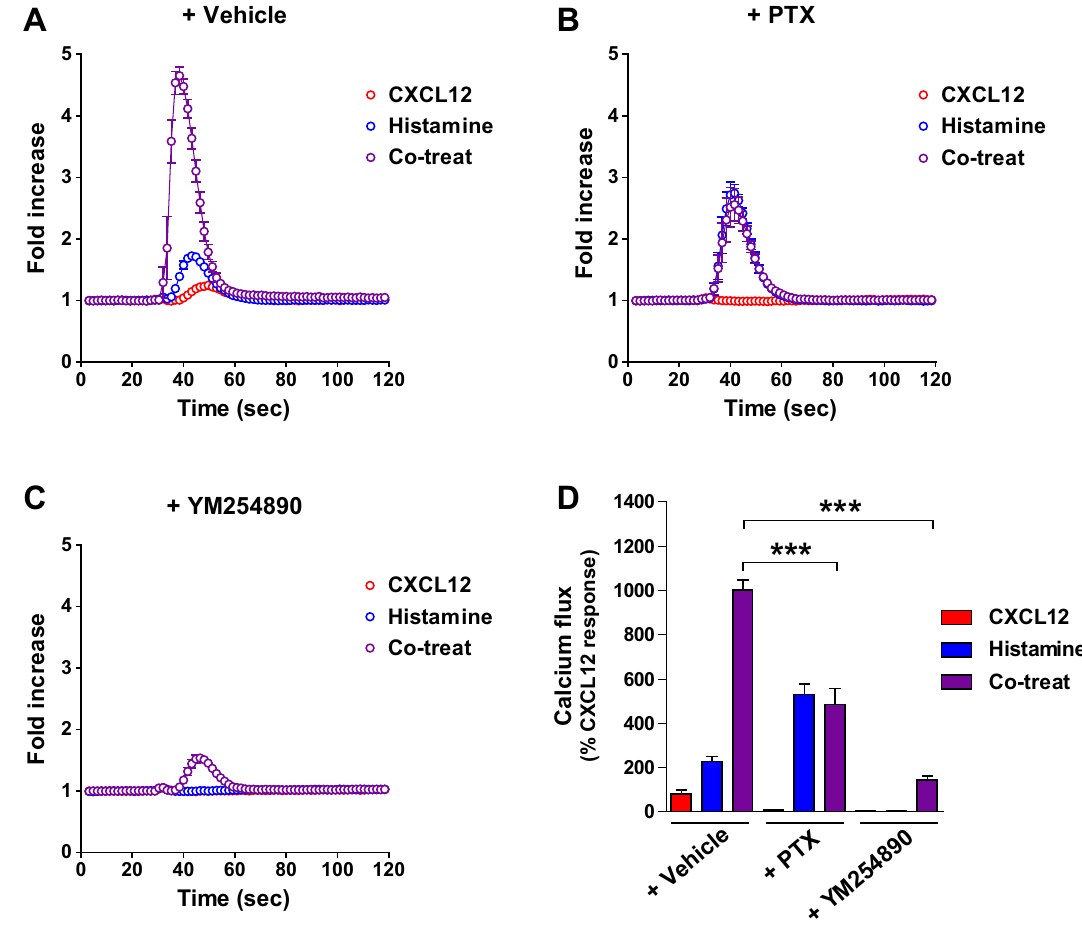
Figure 5. Activation of both Gα i/o and Gα q/11 is important for synergistic calcium mobilization induced by costimulation of CXCR4 and HRH1. MDA-MB-231 cells were pretreated with vehicle ( A ), PTX (100 ng/ml, overnight) ( B ), or YM254890 (300 nM, 30 min) ( C ) prior to agonist treatment. Cells were stimulated with 3 nM CXCL12, 100 nM histamine, or both, and intracellular calcium flux was measured. ( D ) The area under the curve of each calcium response was calculated and normalized to that of CXCL12. Data are expressed as mean ± s.e.m. (n = 3). *** P <